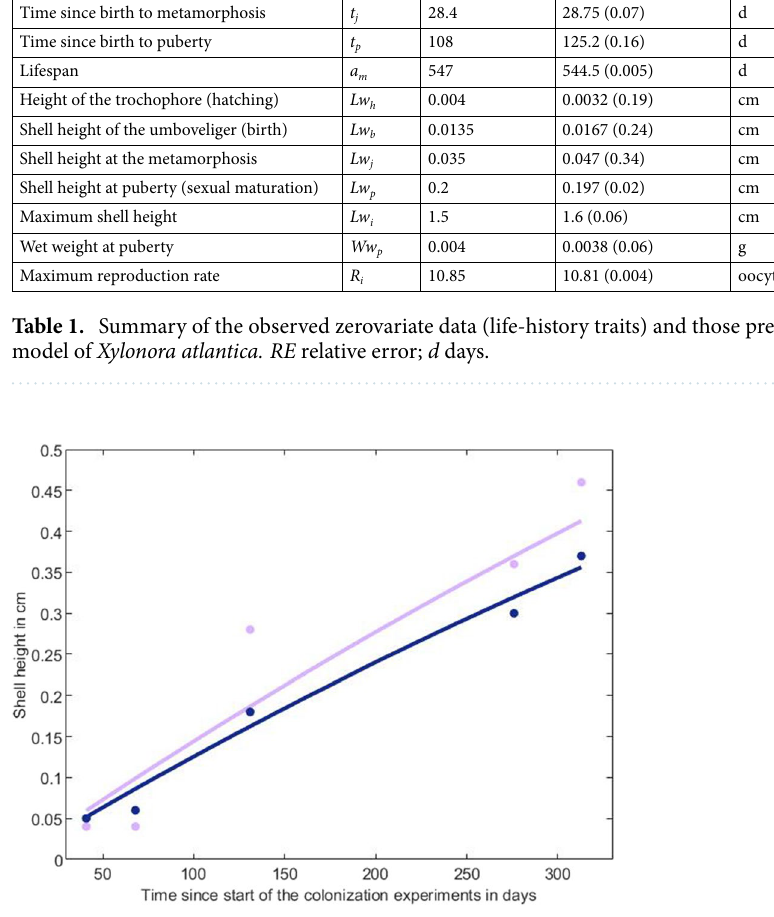
Figure 1. Observed (dots) and predicted (lines) data on the growth of Xylonora atlantica in shell height before and after using the abj-DEB model. Data from the pine substrate are in purple, and those from the oak substrate are in blue. The observed data were obtained from in situ colonization experiments at a depth of 100 m 22 and were the mean values of 8 to 174 individuals depending on the sampling period or wood type. The relative error of the data predicted (RE) for the pine substrate (purple) was 0.19, and the RE for the oak substrate (blue) was